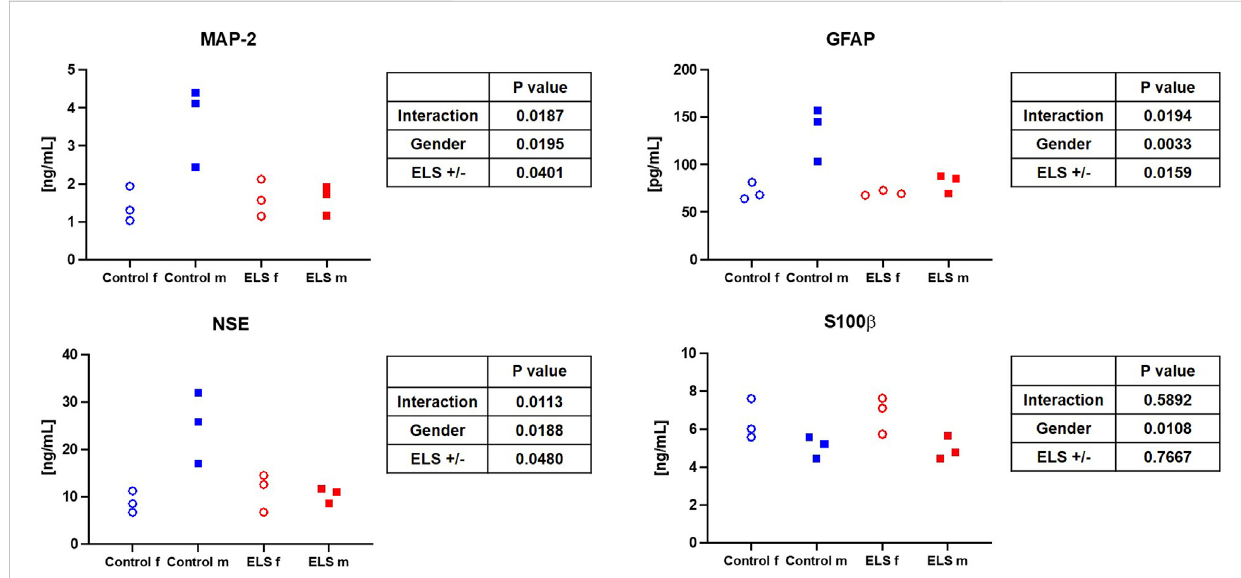
FIGURE 2 Serum microtubule-associated protein 2 (MAP-2) (upper left panel), glial fi brillary acidic protein (GFAP) (upper right panel), neuron-speci fi c enolase (NSE) (lower left panel) and protein S100 β (lower right panel) in the control and Early Life Stress (ELS) groups for the control (blue symbols) and Early Life Stress (ELS; red symbols) groups separated for male ( “ m ” , solid squares) and female ( “ f ” , open circles) swine. Note that male control animals showed markedly higher “ serum brain injury marker ” concentrations than females, while there was no sex-related difference in the ELS swine.